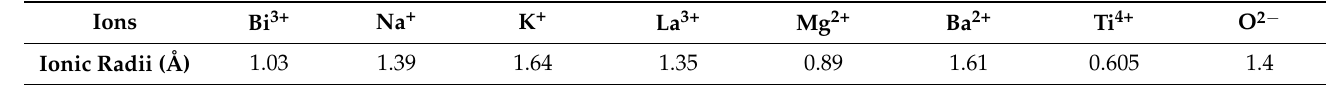
Table 1. Ionic radii of R A , R B and R O